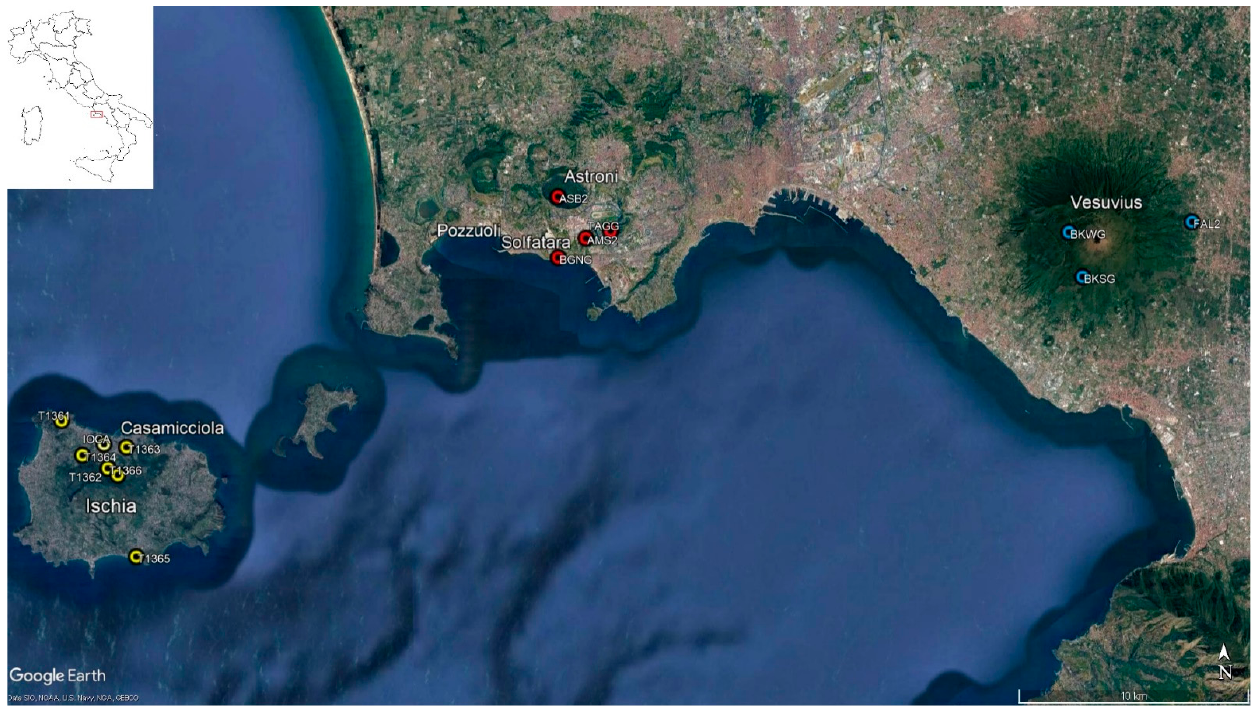
Figure 1. Map of the Neapolitan volcanoes (Vesuvius, Campi Flegrei, and Ischia) with the seismic stations (circles in blue for Vesuvius, red for Campi Flegrei, and yellow for Ischia) used for the